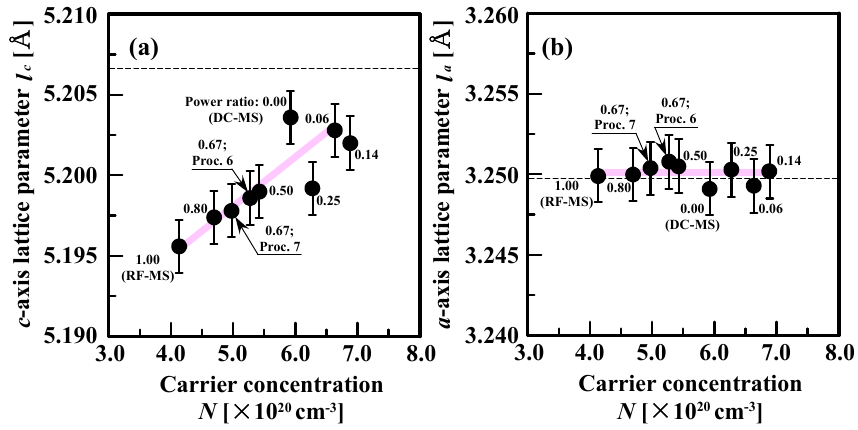
Figure 2. Relationship between ( a ) c -axis lattice parameter ( l c ) or ( b ) a -axis lattice parameter ( l a ) and carrier concentration ( N ) of 500-nm-thick AZO films deposited by DC magnetron sputtering (DC–MS), RF/DC magnetron sputtering at various power ratios and by RF magnetron sputtering (RF–MS).